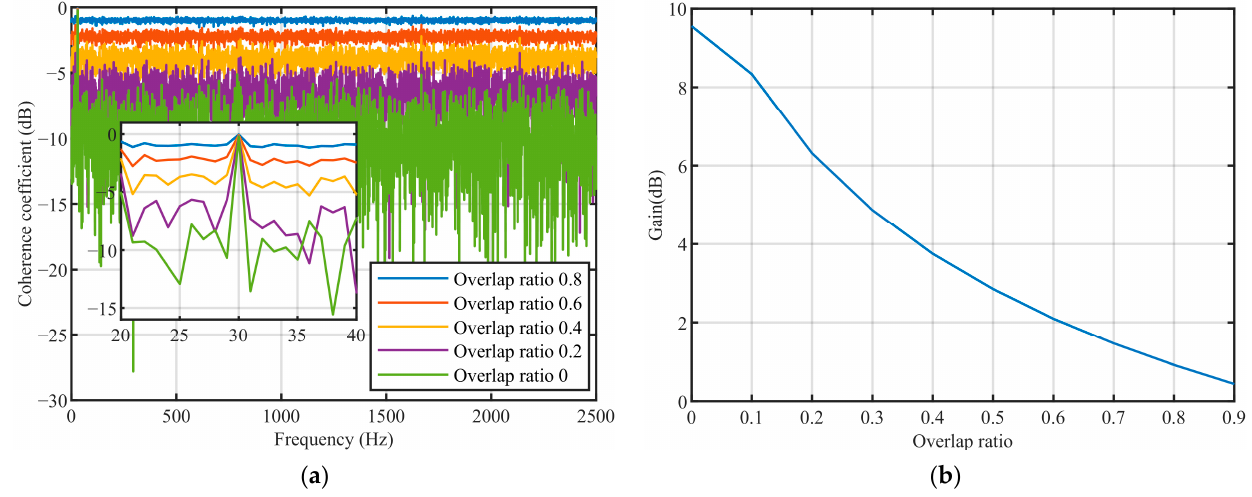
Figure 5. SHCS processing results with different overlap ratios: ( a ) coherence coefficient; ( b ) gain.